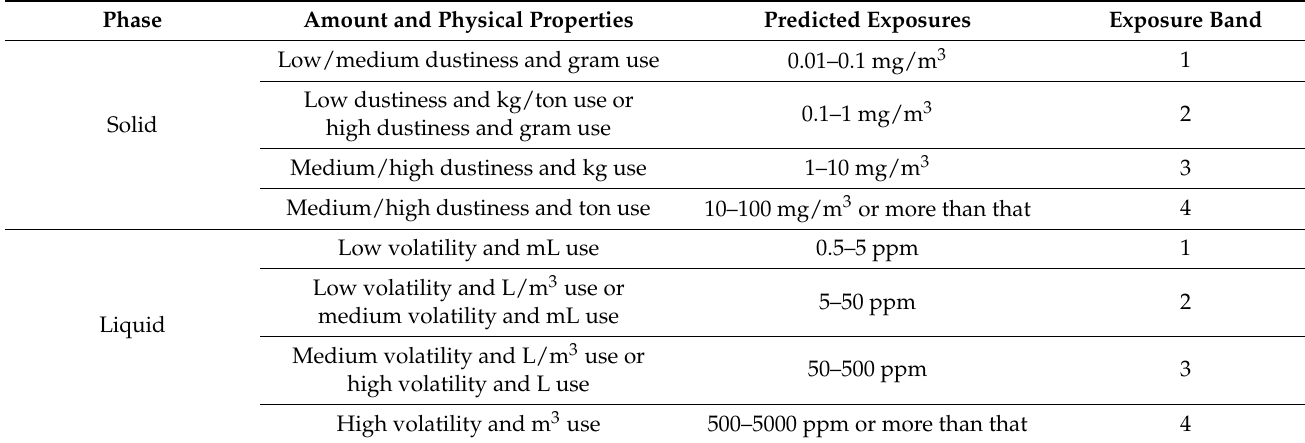
Table 3. Definitions of exposure bands derived from amount and physical